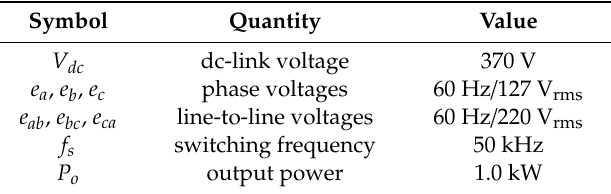
Table 1. Electrical specifications of the inverters.